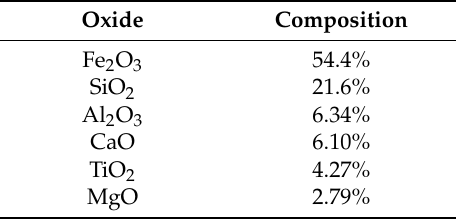
Table 2. Chemical composition of the extracted sample aquired from X-ray fluorescence.